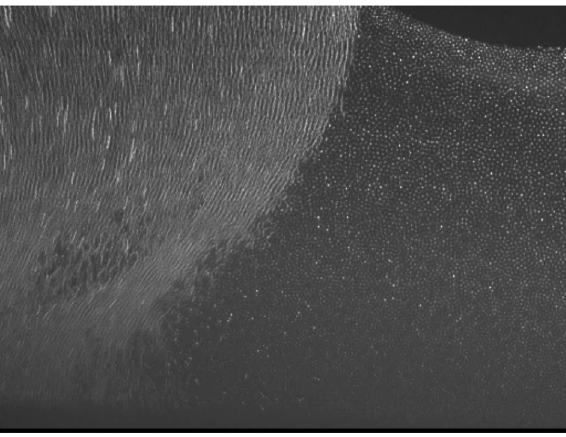
Fig. 6 Turbulence in a complex plasma 83 . Turbulent microparticle fl ow has been observed in a complex plasma experiment.